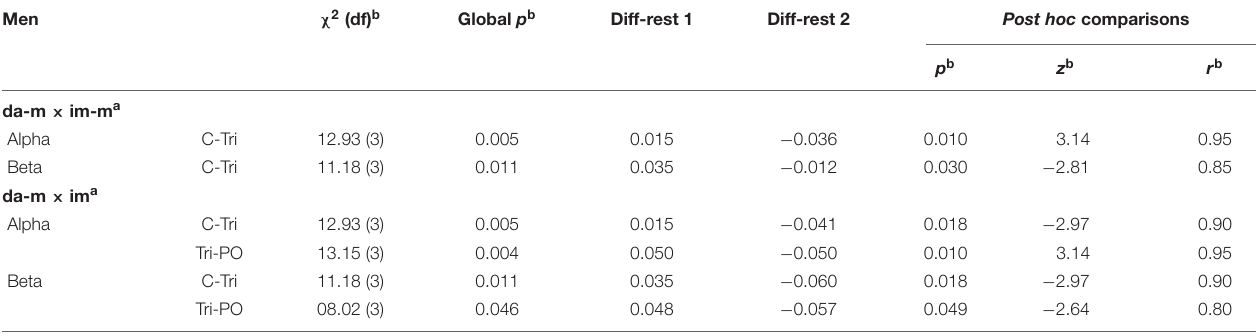
Statistically significant differences between test conditions with the presentation of the Diff-rest values of ICOH. Left column, descriptive values; right column, statistical values. a Statistical differences between test condition pairs, da-m, physically executed dance with music; da, physically executed dance without music; im-m, imagined dance with music; im, imagined dance without music.